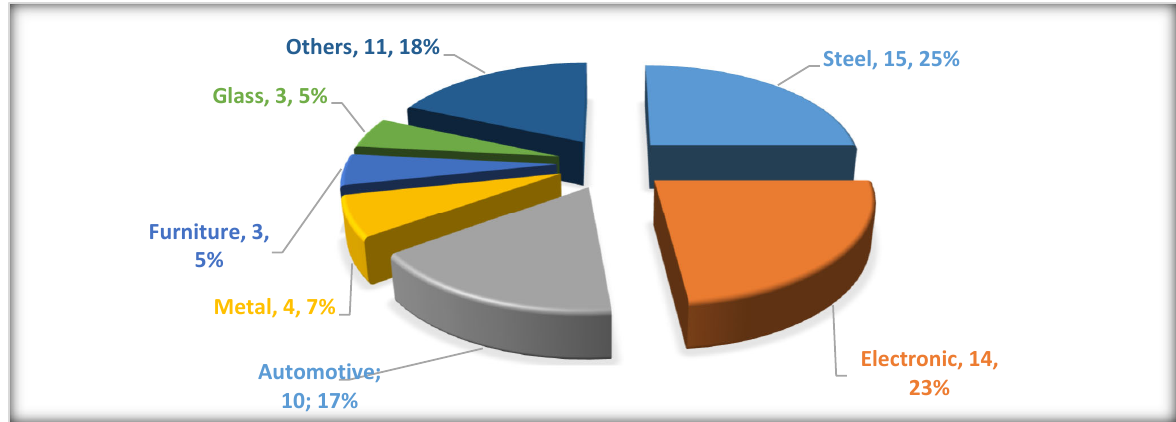
Fig. 20. Percentage distribution of HFS manufacturing problems according to industries